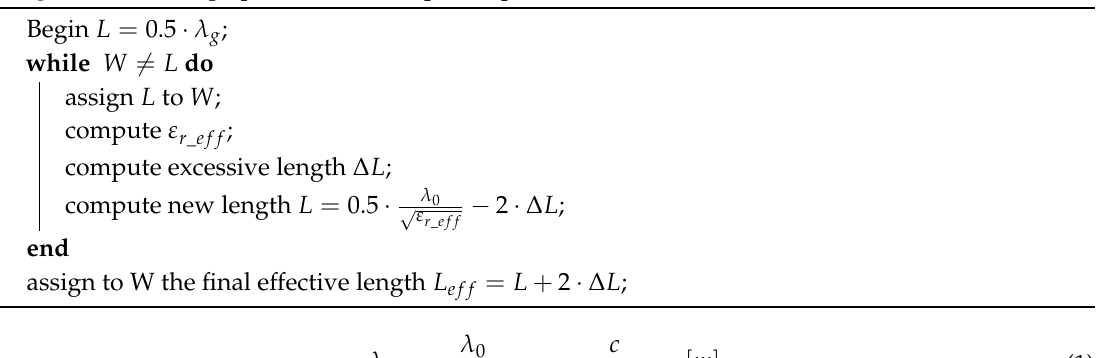
Algorithm 1: Design procedure of a squared patch